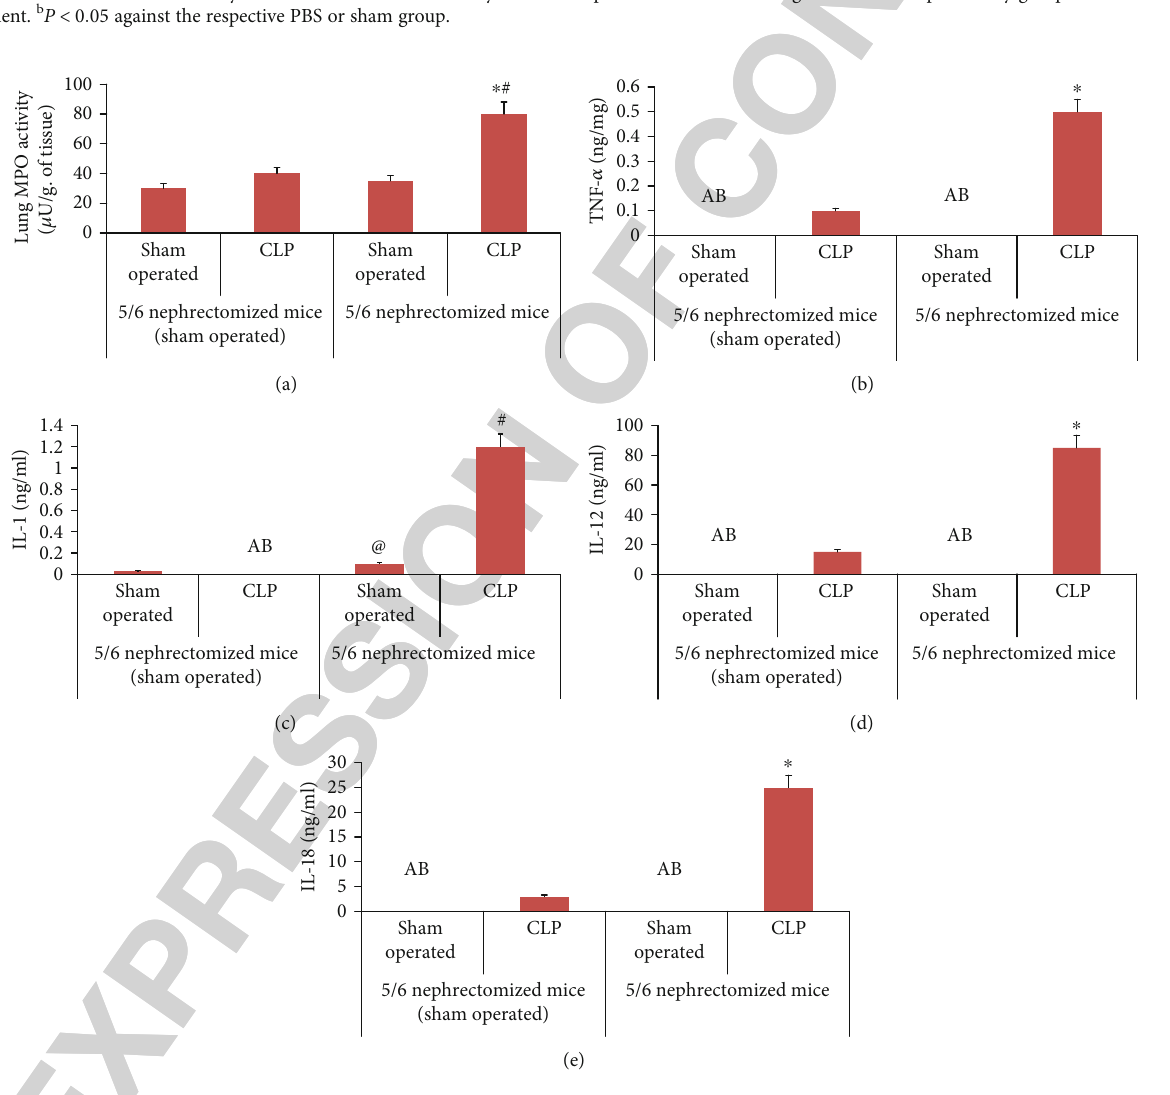
Figure 5: 5/6 nephrectomy-induced chronic kidney dysfunction causes systemic in fl ammation mediated by CLP. The in fl ammatory markers of lung in fl ammation and systemic in fl ammatory markers were evaluated after 24 hours in mice subjected to CLP. (a) MPO activity was assessed in lung tissues. (b) Levels of TNF- α in plasma; (c) levels of IL-1 in plasma; (d) levels of IL-12 in plasma; (e) levels of IL-18 in plasma. All the results are mean ± SEM ; AB: absent; ∗ P < 0 : 05 compared to 5/6 nephrectomized sham mice with corresponding treatment, # P < 0 : 05 compared to the respective sham group, and @ P < 0 : 05 compared to the 5/6 nephrectomized sham group with sham